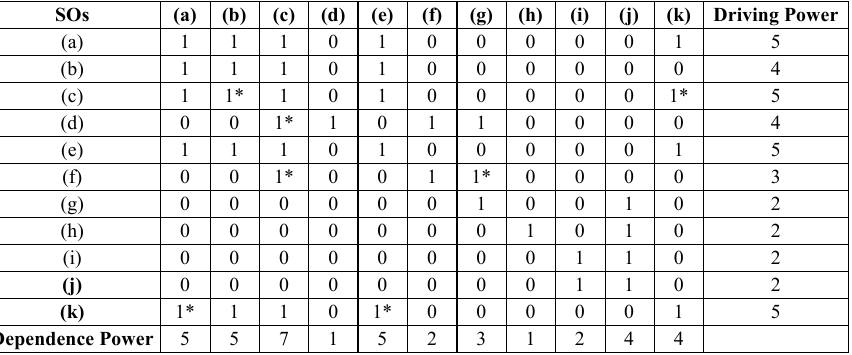
Table 5. Iterations of Labeling in